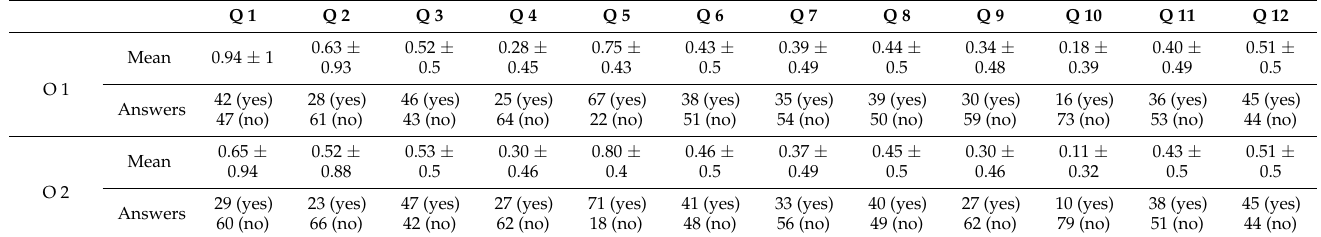
Table 2. Answers to each question. O 1—Observation 1; O 2—Observation 2.